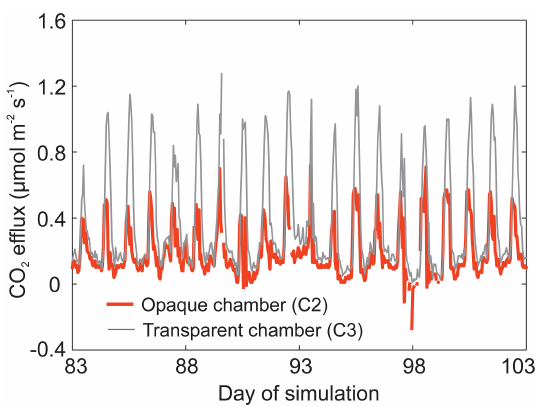
Figure 9. Comparison of the measured F S from lichen-crusted sur- faces using opaque and transparent chambers during a dry period (days 83–103) in spring